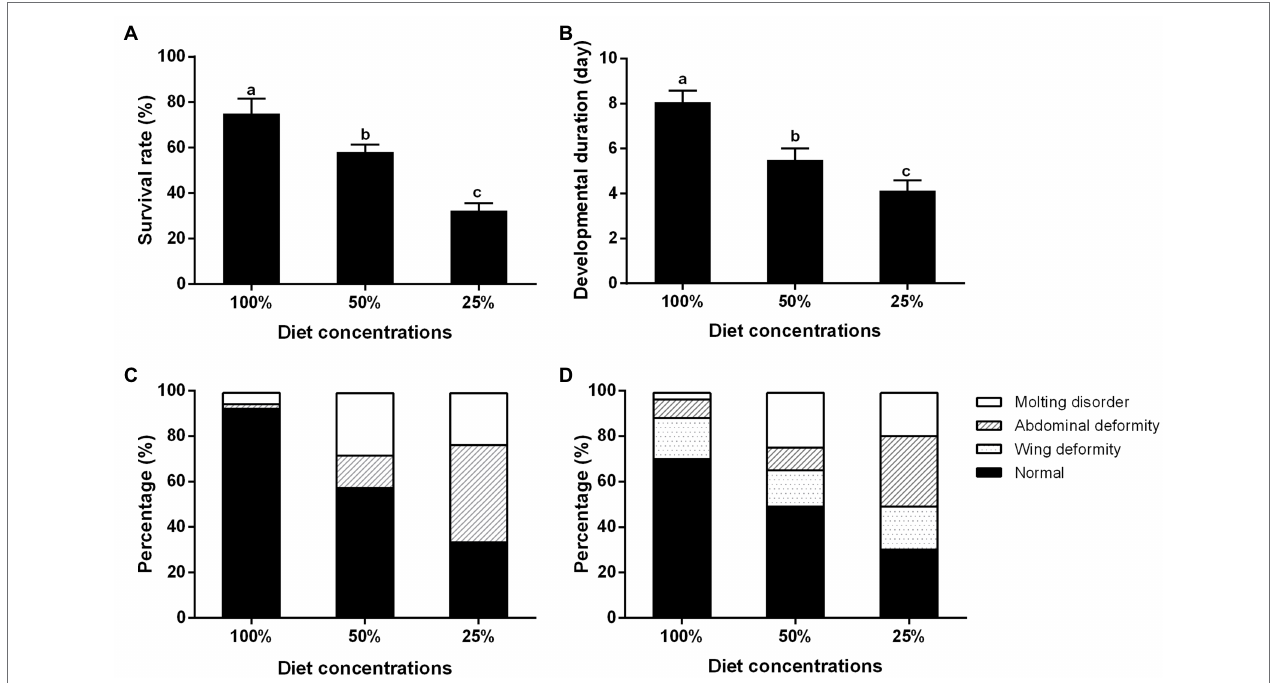
FIGURE 2 | Effects of nutrition on the survival and development of the BPH. (A) Survival rate; (B) Developmental period; (C) Deformity ratio of the BPHs of fifth- instar nymph; and (D) Deformity ratio of the BPHs of adult of 2 day. Data are presented as mean ± SE ( n = 3); different letters above the same index data indicate significant differences ( p < 0.05, Duncan’s multiple range